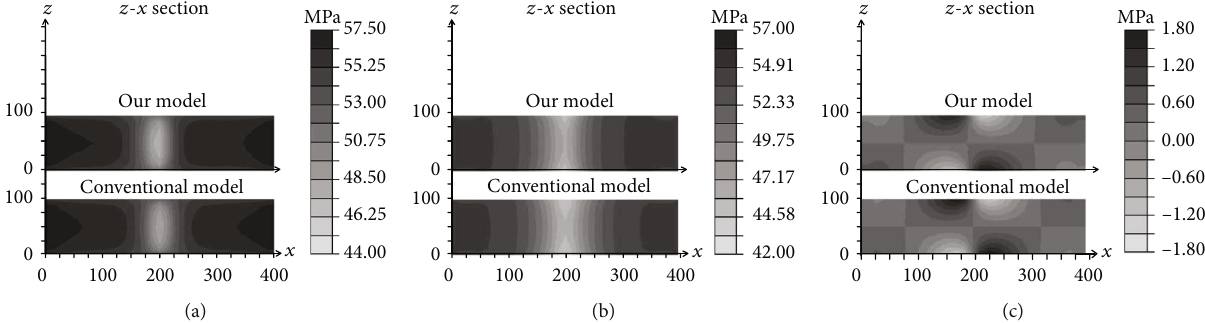
Figure 11: (a), (b), and (c) present the comparison of the principal stress along the x -direction, y -direction, and the induced shear stress on the z - x section,